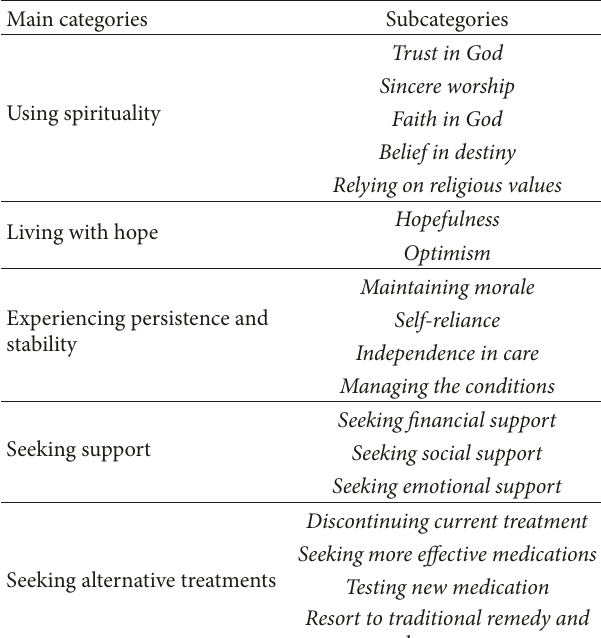
Table 2: Categories and subcategories related to dealing with present